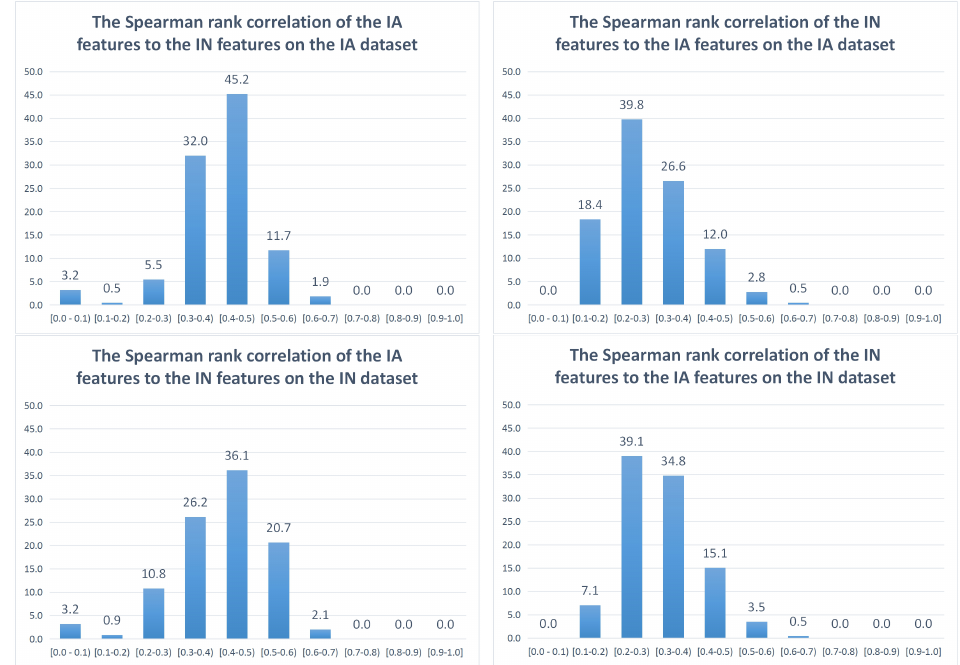
Figure 5. Spearman correlation between IA features and IN